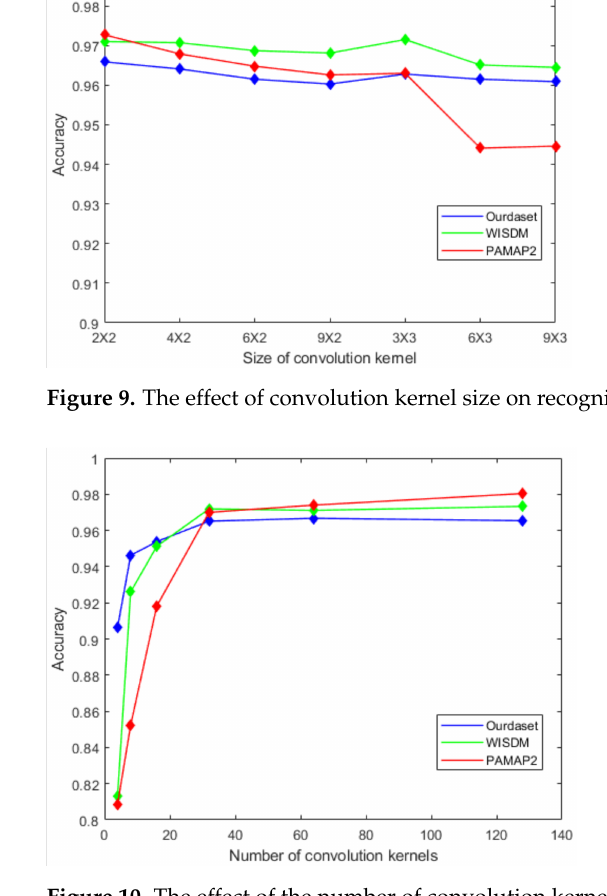
Figure 10. The effect of the number of convolution kernels on recognition accuracy.